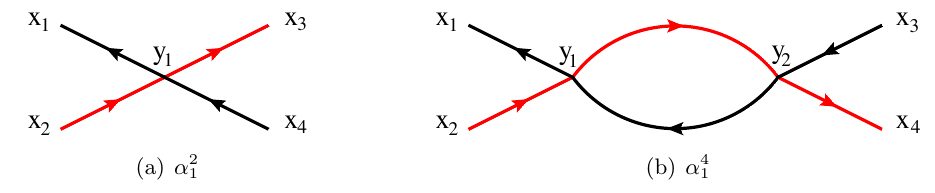
]Tr[ (cid:30) y (cid:30) 2 ] and 2 1